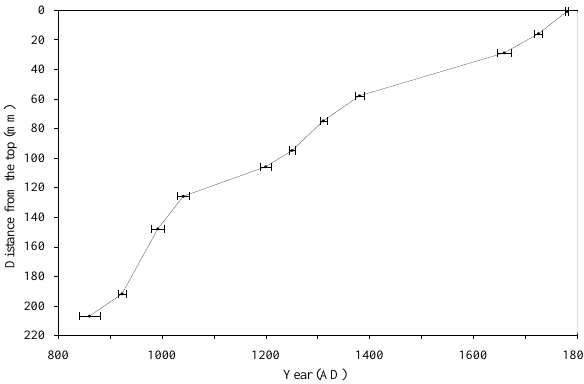
Fig. 3. A 230 Th age model for the stalagmite BD. Black dots with error bars depict 230 Th dates with age errors less than 20yr (Ta- ble 1). The chronology was constructed by linear interpolation be- tween 230 Th